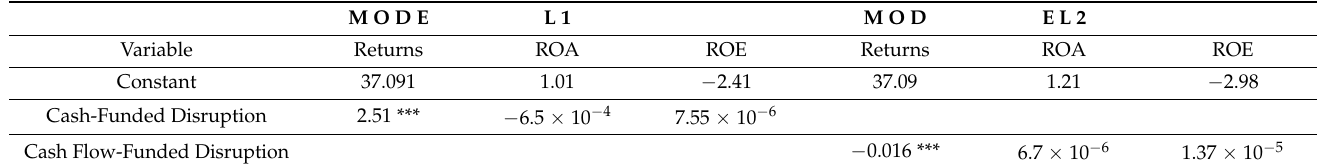
Table 8. Robustness Tests: GMM Estimator Regressions of Returns, ROA, and ROE, on Cash, Cash Flow, with Disruptor/Non-disruptor, Debt Equity Ratio, Equity Multiplier, Short Term Debt, and Total Assets as